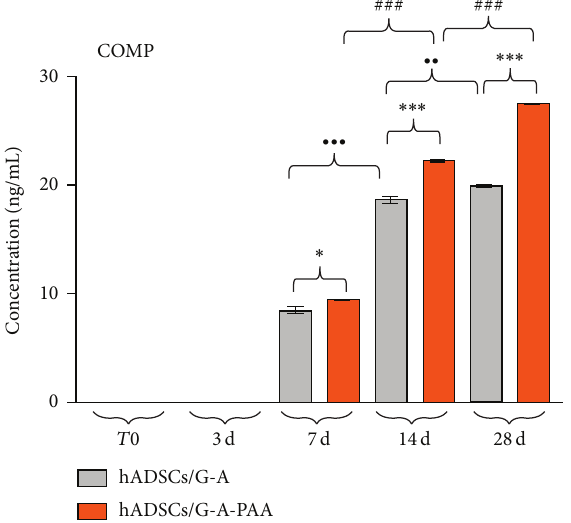
Figure9:COMPexpressioninhADSCs/G-A-PAAandhADSCs/G- A bioconstructs exposed to chondrogenic conditions for 28 days, as revealed by ELISA immunoassay ( ∗ 𝑃 < 0.05 (hADSCs/G-A-PAA versus hADSCs/G-A: 7 days); ∗∗∗ 𝑃 < 0.001 (hADSCs/G-A-PAA versus hADSCs/G-A: 14 days and 28 days); ∙∙ 𝑃 < 0.01 (hADSCs/G- A:28daysversus14days); ∙∙∙ 𝑃 < 0.001 (hADSCs/G-A:14daysversus 7 days); ### 𝑃 < 0.001 (hADSCs/G-A-PAA: 14 days versus 7 days and 28 days versus 14